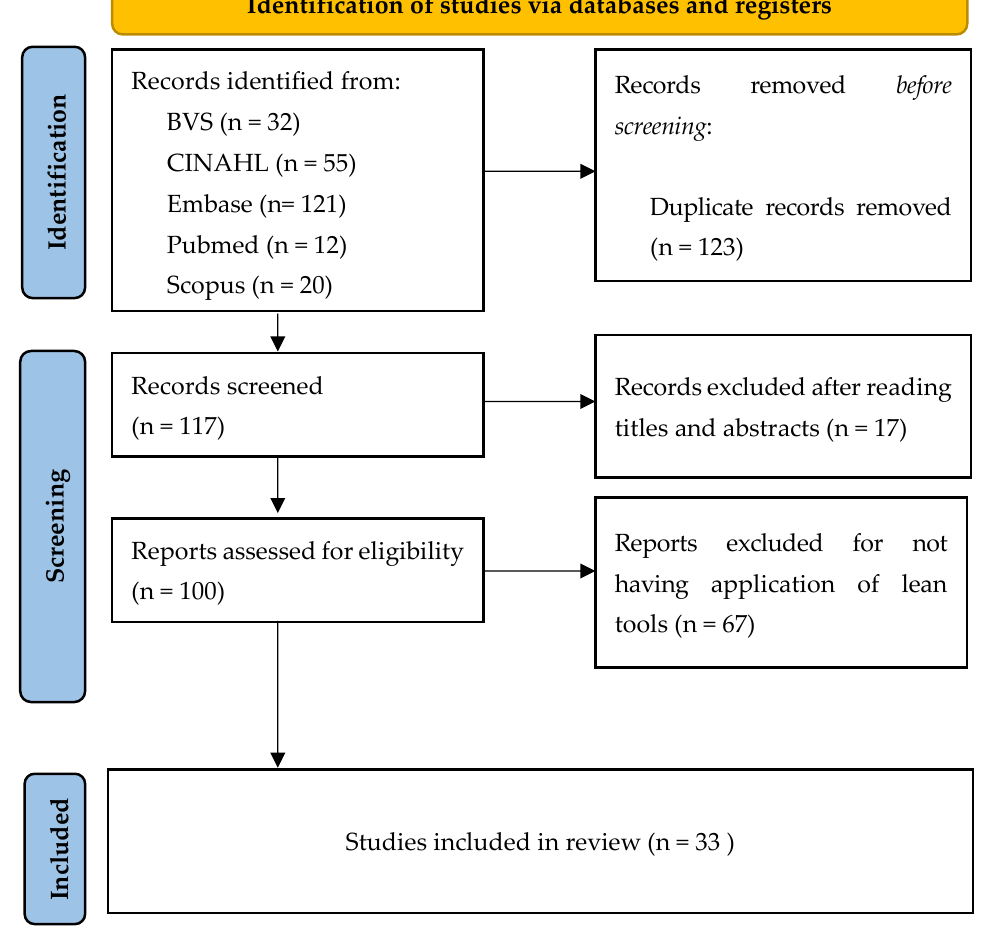
Figure 1. Flowchart of the data collection process adapted from the PRISMA recommendations [18].